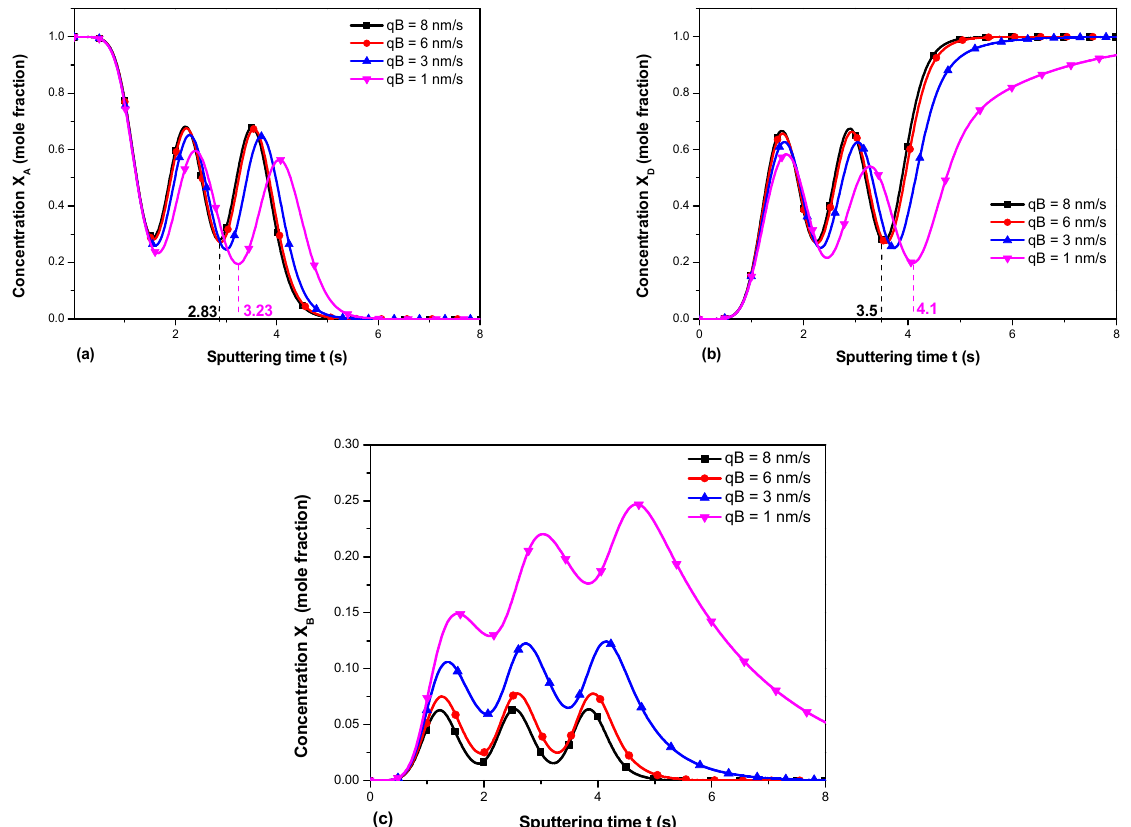
Figure 1. Simulated time-concentration profiles of the multilayer: ( a ) component A, ( b ) component D, and ( c ) component B, for different sputtering rates of component B in delta layer with a thickness of 0.5 nm.